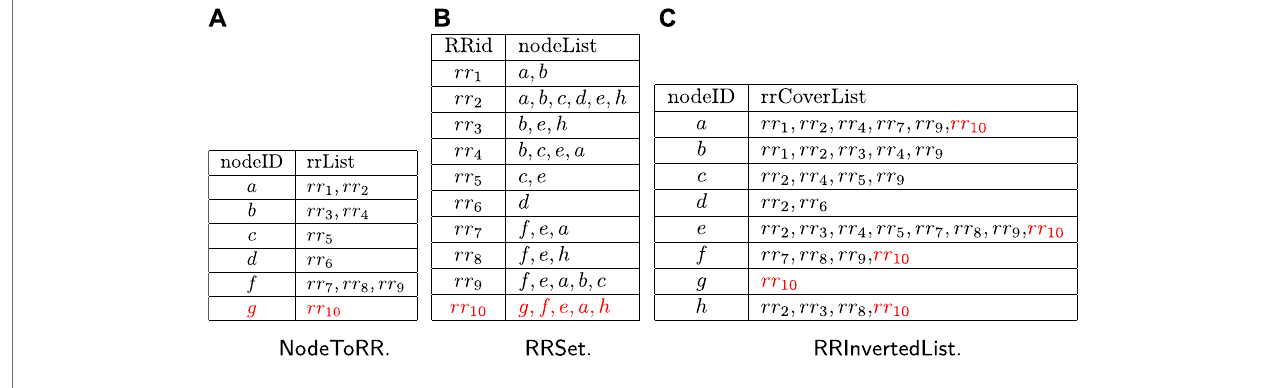
FIGURE 6 | Index structures for the random RR sets.